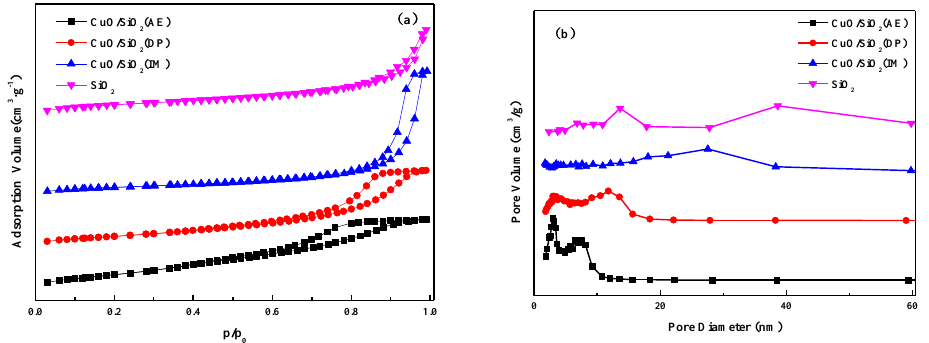
Figure 1. ( a ) N 2 adsorption–desorption isotherms and ( b ) pore size distribution curves of CuO/SiO 2 catalysts. Table 1. Textural properties of CuO/SiO 2 catalysts.